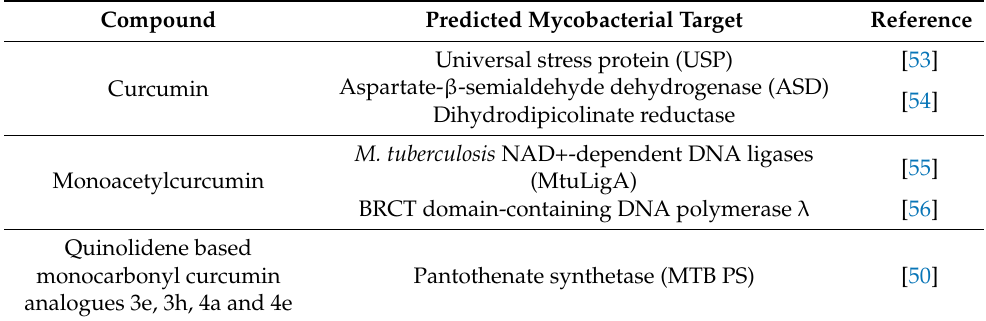
Table 2. Predicted targets of Curcumin and its analogues by computer-aided drug